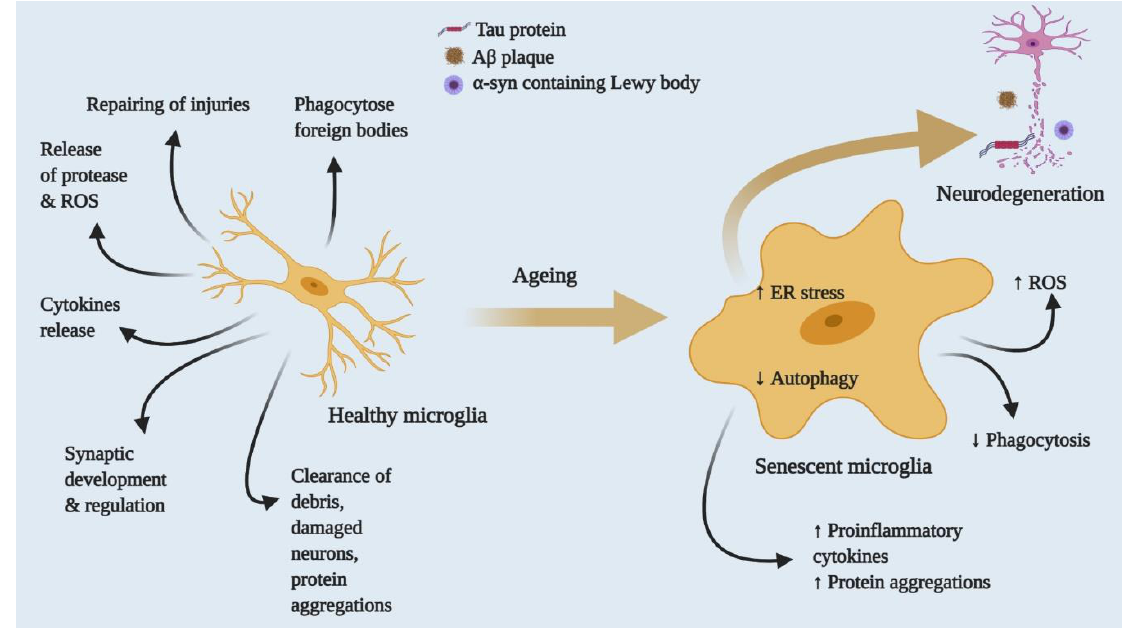
Figure 3. Effects of ageing on healthy to proinflammatory microglia. Healthy microglia regulate the release of cytokines, proteases, ROS and RNS and phagocyte foreign bodies. In addition, they clear cell debris and proteins. With advanced ageing, microglia eventually lose function or functions dysregulated by persistent exposure to foreign bodies or mutations. Increasing microglial ROS production releases proteases and cytokines and slows the autophagic process, leading to aberrant protein aggregation and inflammatory response, neuronal death and neurodegenerative disease.